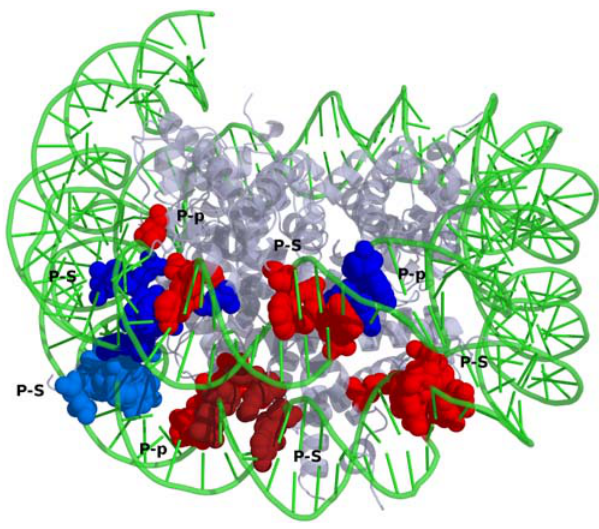
Figure 8. An overview of differences in the pattern of clusters observed due to the presence of linker in the nucleosome core particle. The superposition of the two structures is done using Align. (Only 1aoi is represented in the above figure for clarity.) The clusters that remain unperturbed in both the structures are given in red. The new clusters that are formed due to the conformational changes mediated by the presence of the linker are given in blue. Significant P-B clusters were not seen in both the structures. The composition of the clusters in the linker region is given in Table S4.